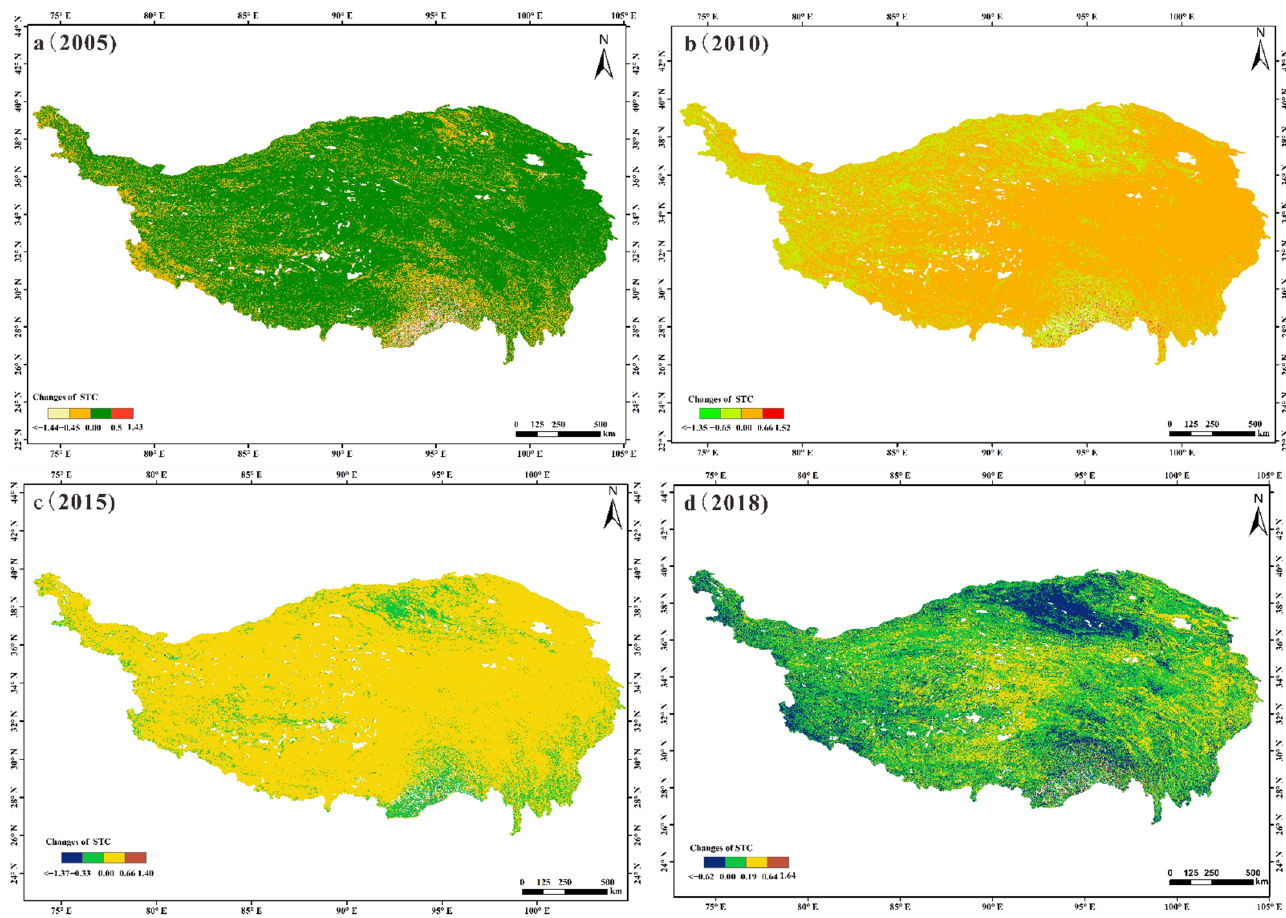
Figure 12. Spatial distribution of interannual STC changes (value = STCthawing − STCfreezing) during the thawing ( a , c ) and freezing periods of the Qinghai–Tibet Plateau from 2005 to 2018 ( b , d ). (1) Interannual changes in the spatial distribution of the thermal conductivity dur- ing the thawing and freezing